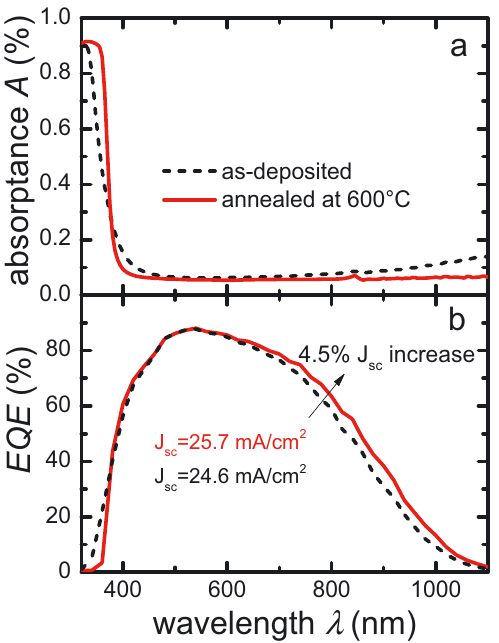
Fig. 2. (a) Absorptance A as a function of wavelength of glass/ZnO:Al superstrates with and without a post-deposition annealing treatment at 600 ◦ C for 5.5 h. (b) External quan- tum efficiency EQE of the solar cells deposited on these super- strates. The corresponding photocurrent values ( J sc ) are given in the